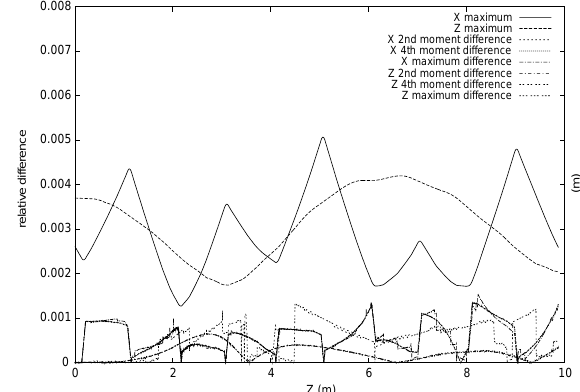
FIG. 4. The relative difference and maximum particle ampli- tude as a function of position using zero current in the reference